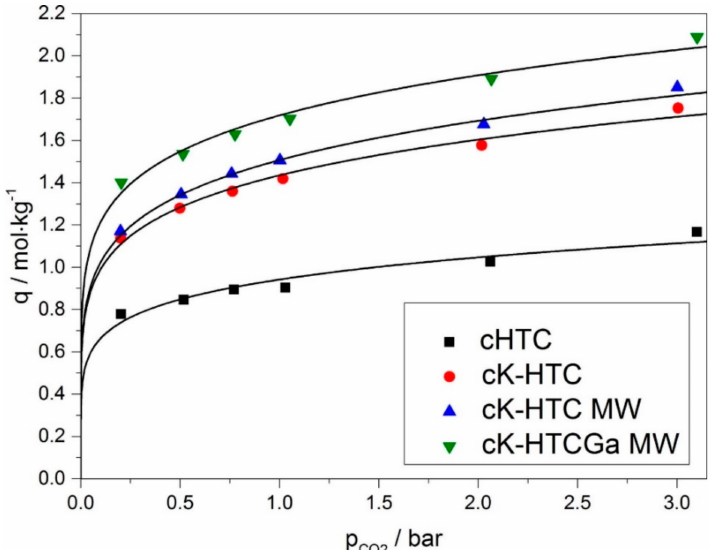
Figure 14. CO 2 sorption equilibrium isotherms at 300 ◦ C on the calcined HTCs. The lines correspond to the fitting using the Freundlich equation (cHTC—calcined HTC; cK-HTC—calcined K-promoted HTC; cK-HTC MW—calcined K-promoted HTC aged under microwave irradiation; cK-HTCGa MW—calcined K-promoted Ga-substituted HTC aged under microwave irradiation). Reprinted with permission from Ref. [209]. Copyright 2021